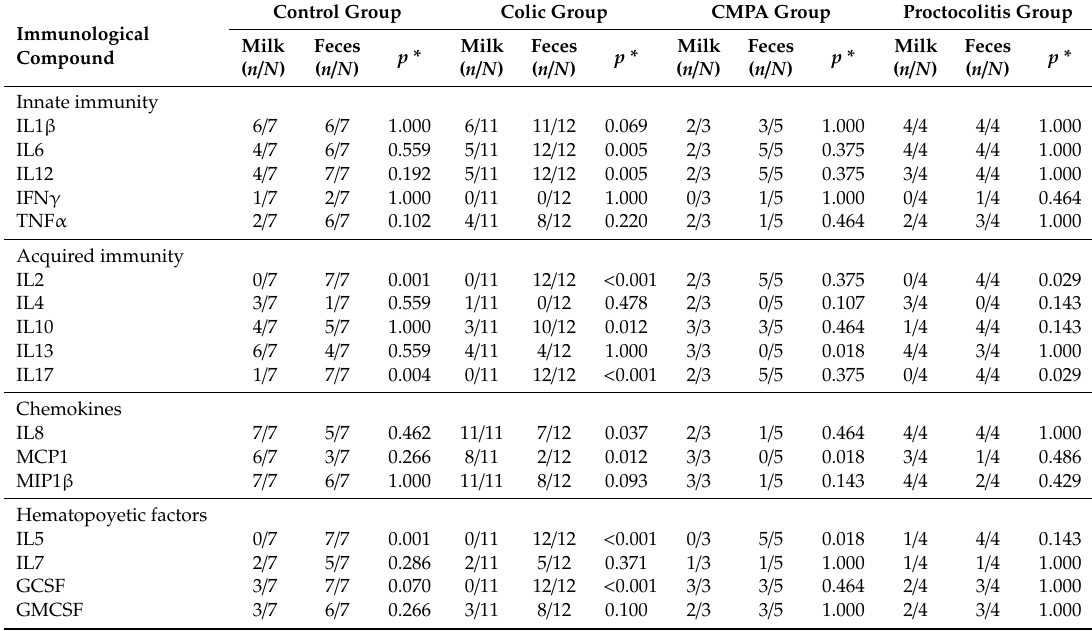
Table 6. Frequencies of detection of immunological compounds in milk ( n = 25) and fecal ( n = 28) samples in each group of study: control, colic, cow’s milk protein allergy (CMPA), and